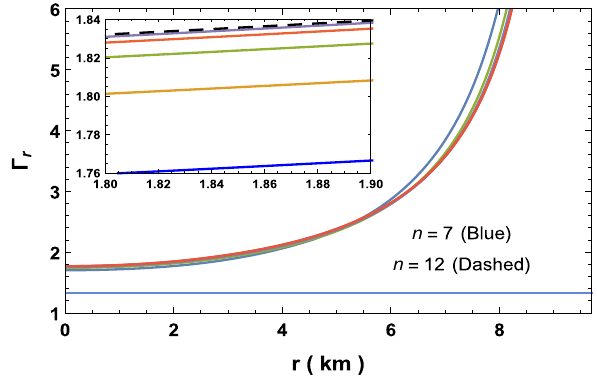
Fig. 9 TOV-equation profile of PSR J1614-2230 for M = 1 . 97 M (cid:6) , R = 9 . 69 km and b = 0 . 04